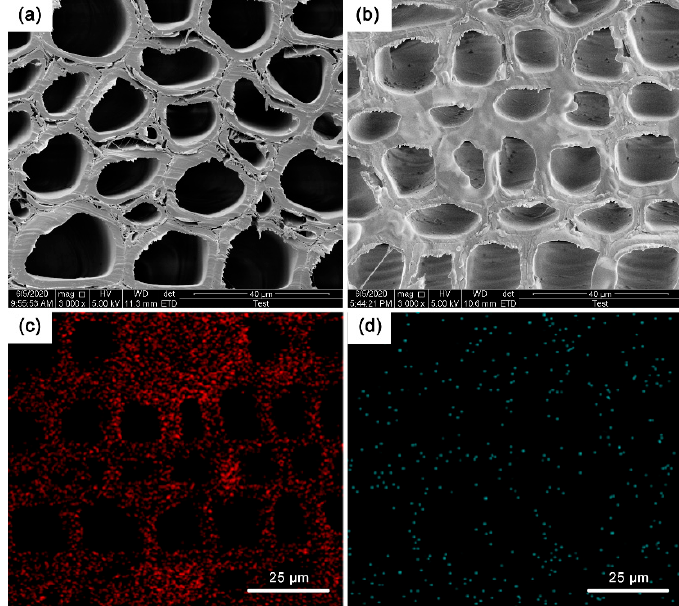
Figure 4. Morphologies of ( a ) untreated and ( b ) emulsion treated wood samples. ( c , d ) were the C element distribution and Si element distribution images of treated sample, respectively. After impregnation, the cell lumen walls were covered by a layer of waxy substrate, and the middle lamella and cell corners of wood were also filled with wax. The distribution of Si element in wood structure indicated the SiO 2 penetrated into wood along with the wax.